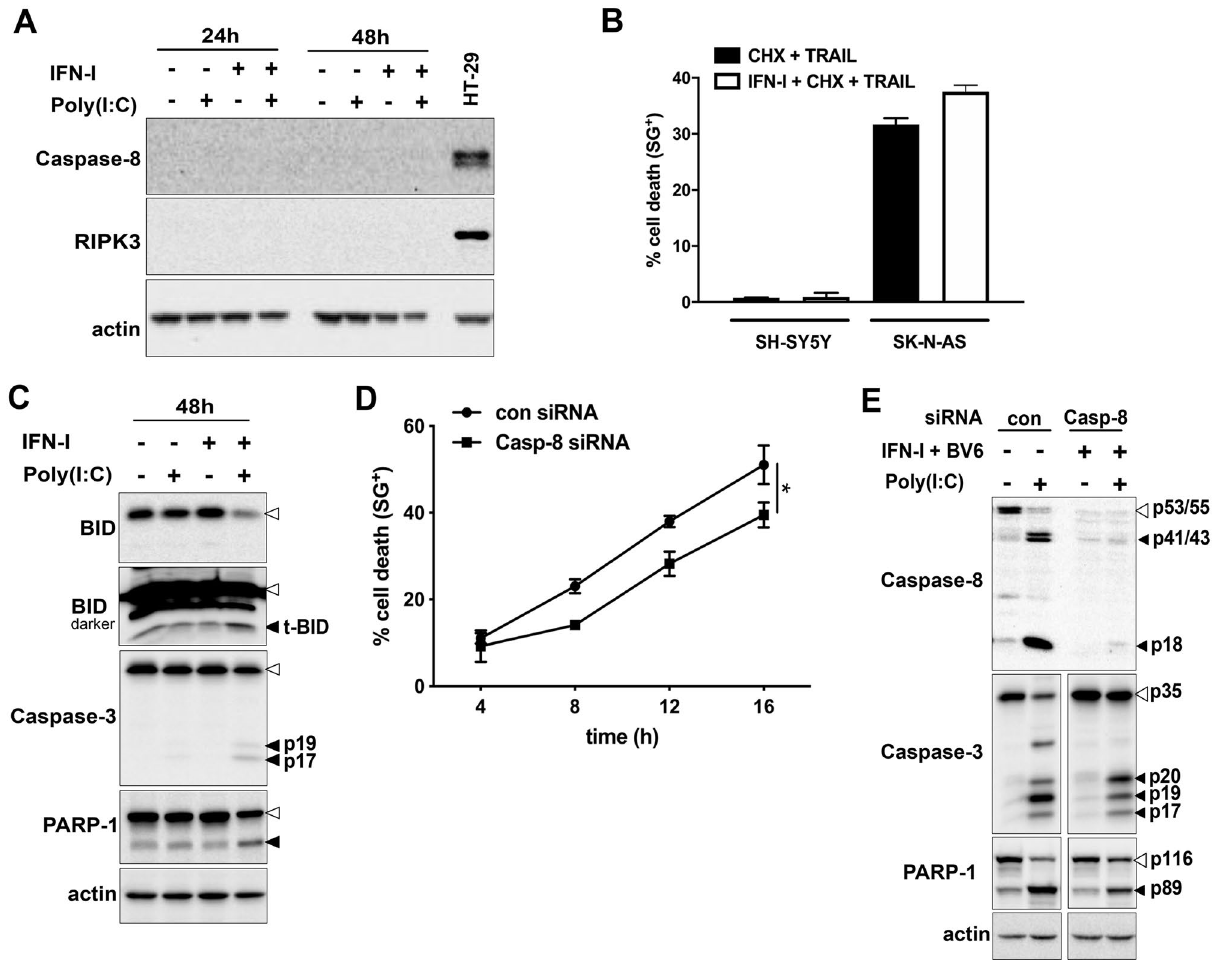
Figure 2. TLR3-induced cell death activates caspases independently of Caspase-8. ( A ) Expression levels of Caspase-8, RIPK3 and MLKL in SH-SY5Y cells following treatment with IFN-I/Poly(I:C) for 48 h. HT29 cells were used as a positive loading control. ( B ) Cell death profile of SH-SY5Y cells treated with IFN-I/TRAIL for 36 h. The percentage of SG + cells was analyzed and profiles are expressed as mean ± S.E.M. n = 2. ( C) Western blot analyses of the processing of Bid, Caspase-3 and PARP-1 following IFN-I/Poly(I:C) treatment for 48 h. Pro-forms are indicated by an empty arrowhead, while the cleavage products are indicated by black solid arrowheads. Actin was used as a loading control. (D) Cell death profile of SK-N-AS cells transfected either with control (con) or Caspase-8 (Casp-8) siRNA for 72 h and treated with BV6 + IFN-I + Poly(I:C). Cell death was determined by SG uptake and data points represent the mean ± S.E.M. of at least three independent repeats. *p < 0.05 (E) Caspase-8, Caspase-3 and PARP-1 cleavage following BV6 + IFN-I + Poly(I:C) treatment of SK-N-AS transfected with control (con) or Caspase-8 (Casp-8) siRNA. Pro-forms are indicated by an empty arrowhead, while the cleavage products are indicated by black solid arrowheads. Actin served as loading